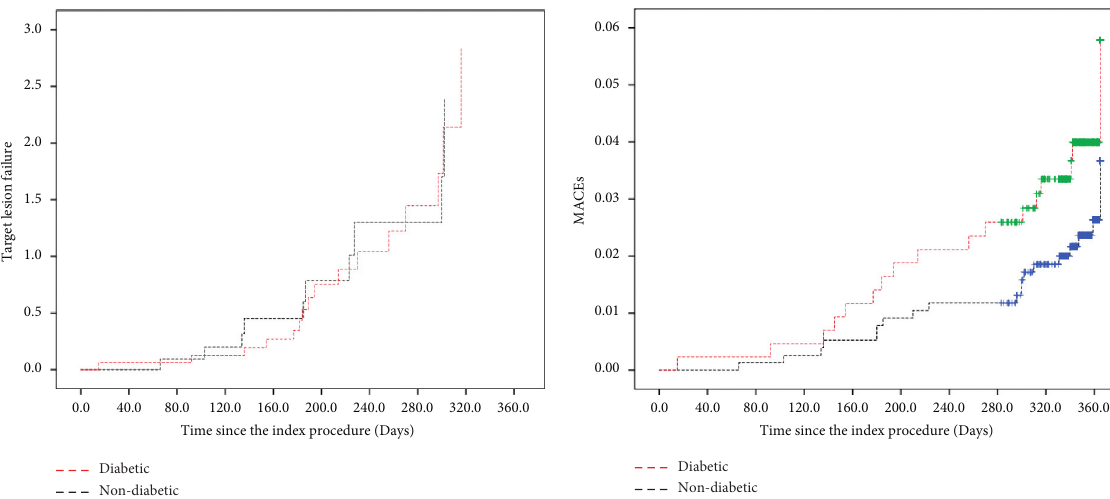
Figure 3: Kaplan–Meier curves of the TLF and MACE at 12 months. MACEs: major adverse cardiac events; TLF: target lesion failure. Table 5: Cox proportional hazard multivariate analysis for TLF and